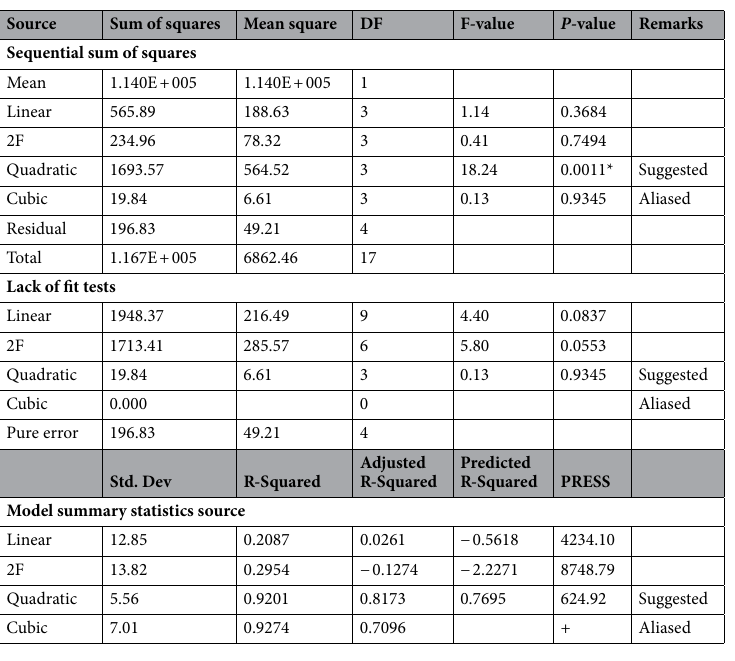
Table 6. Sequential model fitting for the total phenolic content. *statistically significant: p ˂ 0.05.